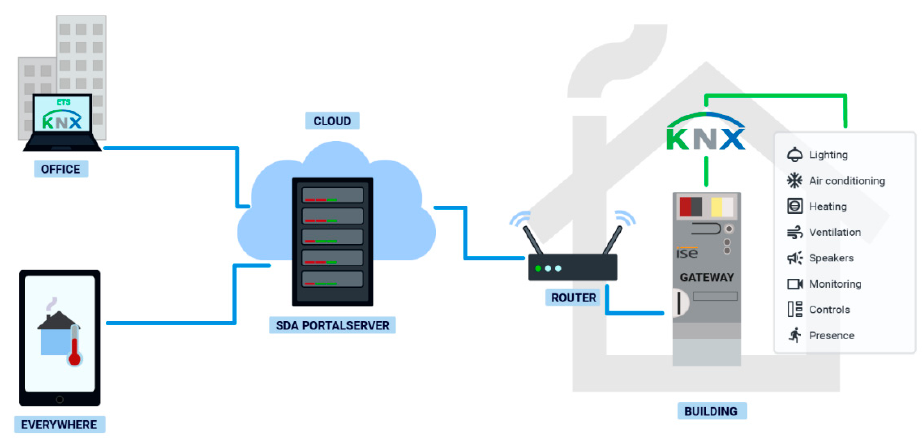
Figure 4. The procedure for collecting measurement data from the office